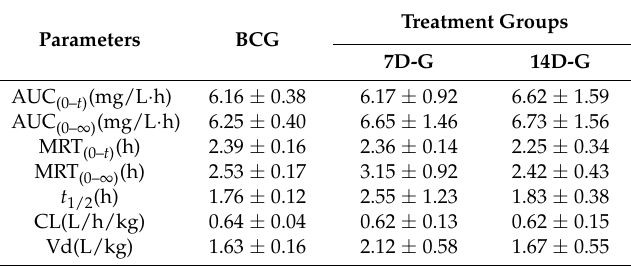
Table 6. Effects of SGI on pharmacokinetic parameter of midazolam (4.0 mg/kg).